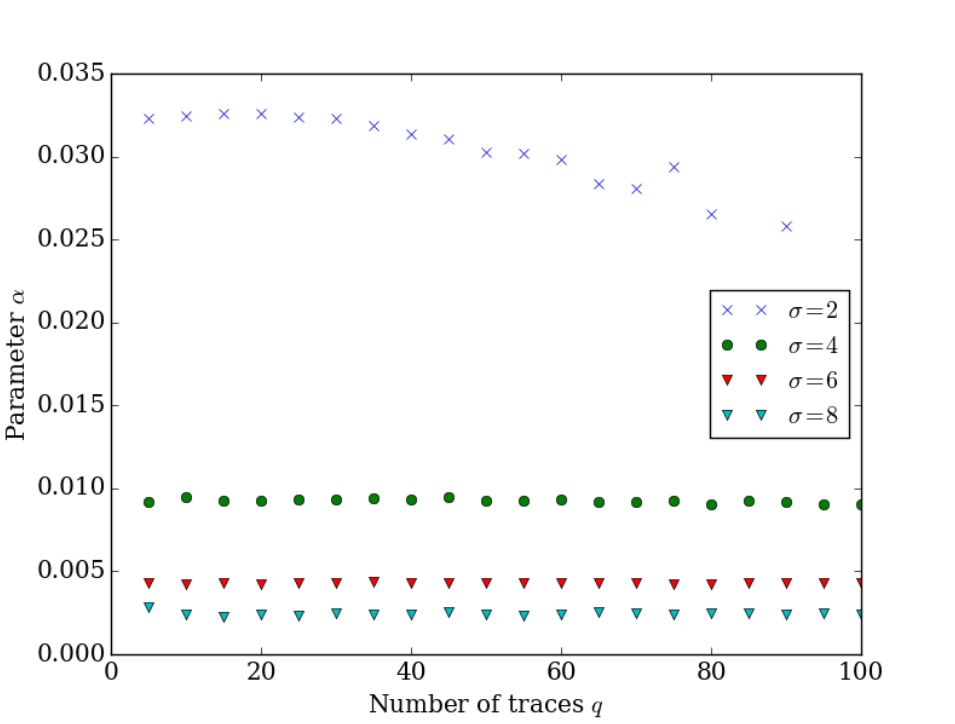
Figure 7: Estimation of parameter